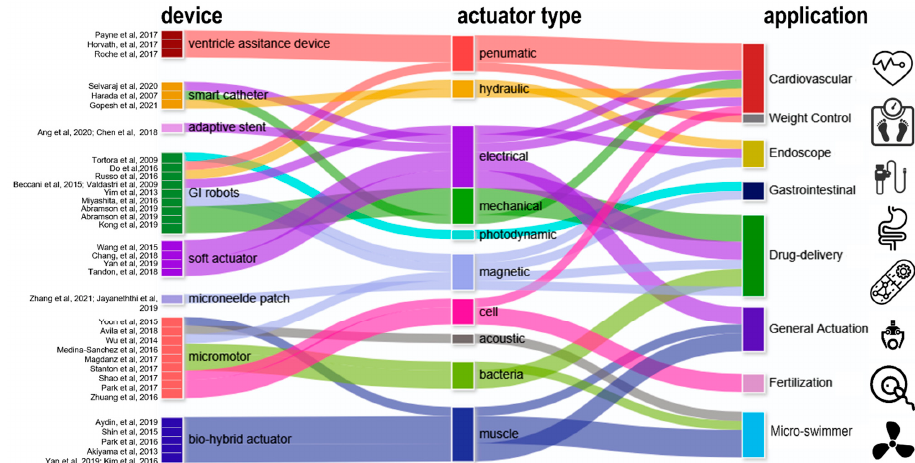
Figure 1. Actuators in various biomedical devices for major in-body applications